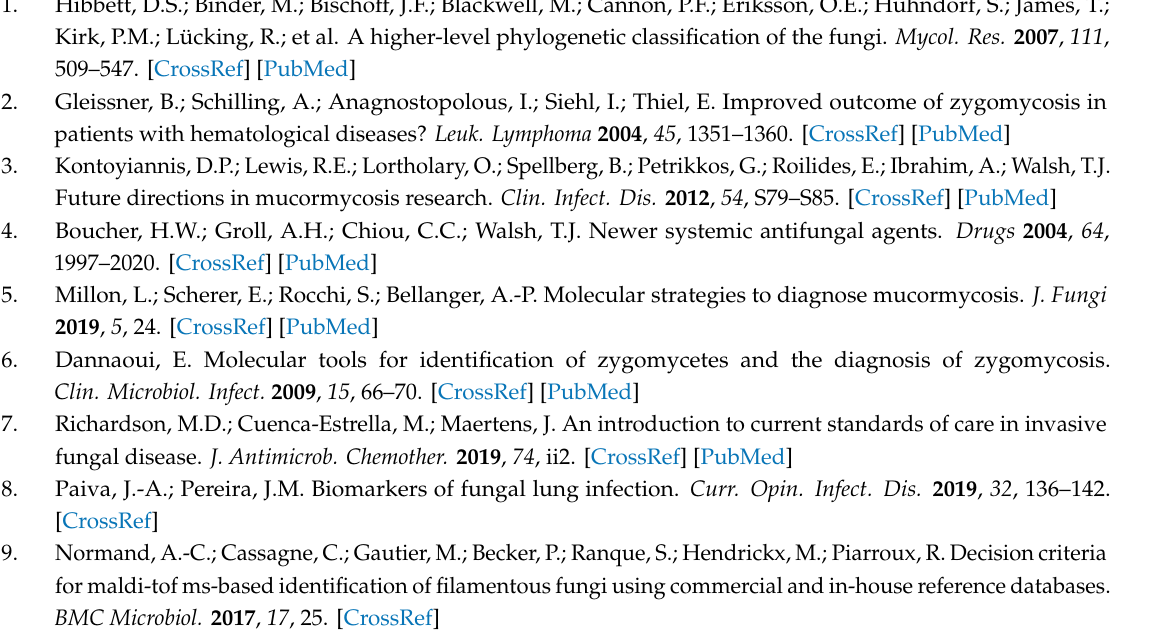
circinelloides is colored in light blue; the other fungal organisms exhibit no melt peak and these plots are colored in black. (C,D) The results observed for the high-resolution melt analysis step processed by using the Precision Melt Analysis ™ software v 1.2. (C) The areas shaded in green and in red are the pre- and post-melt regions, respectively; the raw melt curves are depicted, before normalization, showing the melt curves generated for the positive Mucorales controls in colors, and the black lines shown in the graph represent the plots for the non- Mucorales organisms, for which no melt curves are observed. (D) Depicts a typical di ff erence curve for the four Mucorales positive controls analyzed, by using as reference cluster the melt profile generated for M. circinelloides . Figure S3: Amplification plots and respective melt peaks obtained for the serial dilution of 106 to 10-1 conidia spiked in human whole blood samples for defining limit of detection (LoD). The strain R. arrhizus KOG-D3 was used for the spiking experiment. (A) Amplification plots show a positive amplification until the lowest tested concentration (0.1 conidia / PCR reaction), at an average Ct of 36.98. (B) Respective melt peaks are also shown to be linear until the same concentration. Figure S4: Limit of detection (LoD) of rnl real-time PCR-HRM for EDTA-treated human whole blood samples spiked with mucoralean DNA. Range of linearity, trend line with coe ffi cient of determination and linear equation, as well as Ct values for the corresponding dilution steps are shown for (A) L. corymbifera , (B) R. arrhizus , (C) M. circinelloides , (D) L. ramosa , and (E) R. microsporus . Green shaded boxes indicated the level of linearity of the curve that enables the values R 2 to be calculated. LoD is marked as the right margin of the green box. Figure S5: Divergence in real-time PCR Ct values observed by rnl marker and tef housekeeping gene marker. Growth stages of (A) spores, (B) germlings, and (C) hyphae were determined using a ten-fold dilution series of fungal DNA (% of total DNA concentration of 10 ng / µ L) in EDTA-treated human whole-blood-spiked samples. Ranges and mean values are given as overall results for the species Lichtheimia spp. complex, R. arrhizus , R. microsporus , and M.